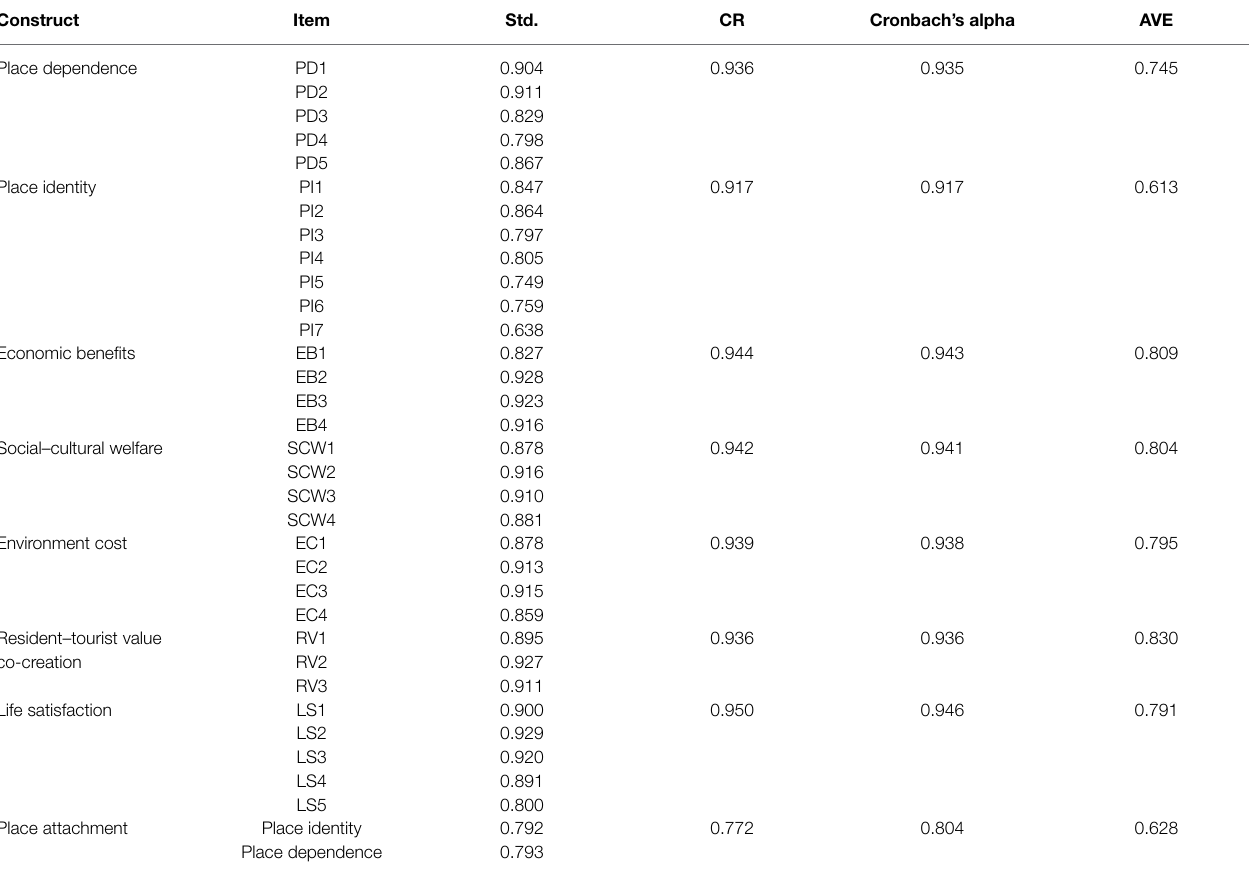
TABLE 5 | Convergent validity.